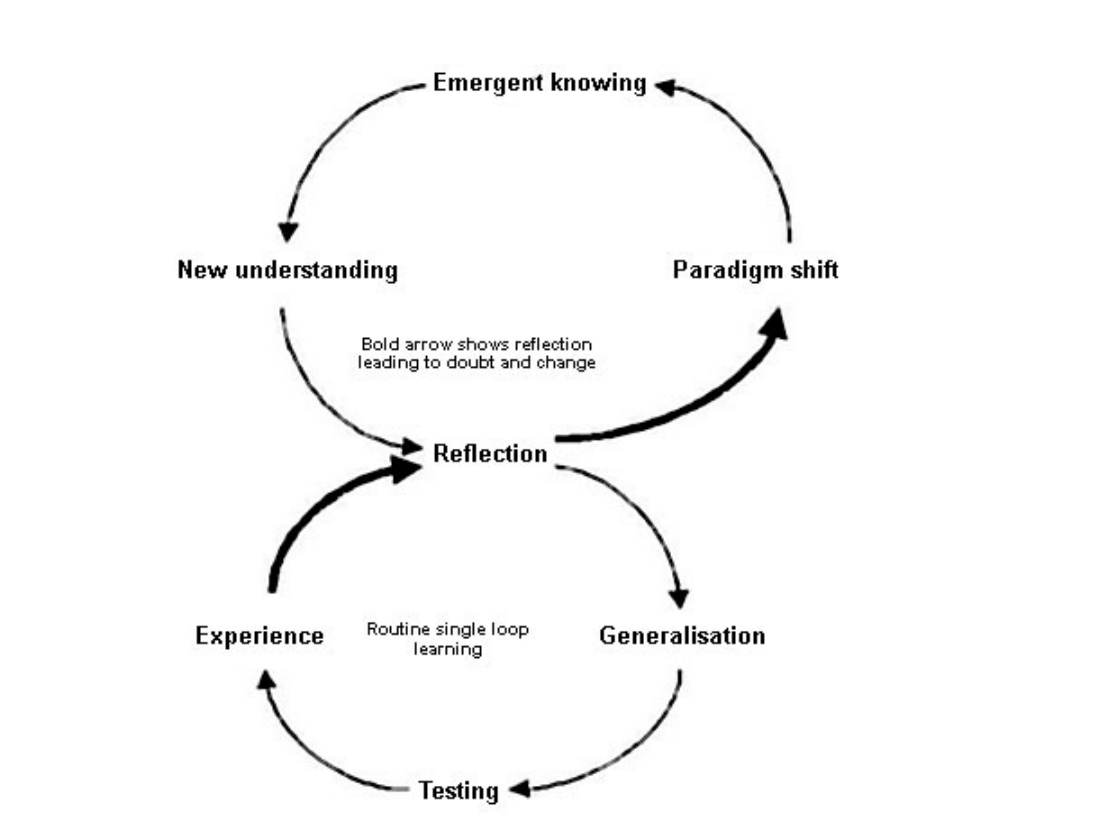
Fig. 3. Double-loop learning (Brockbank and McGill